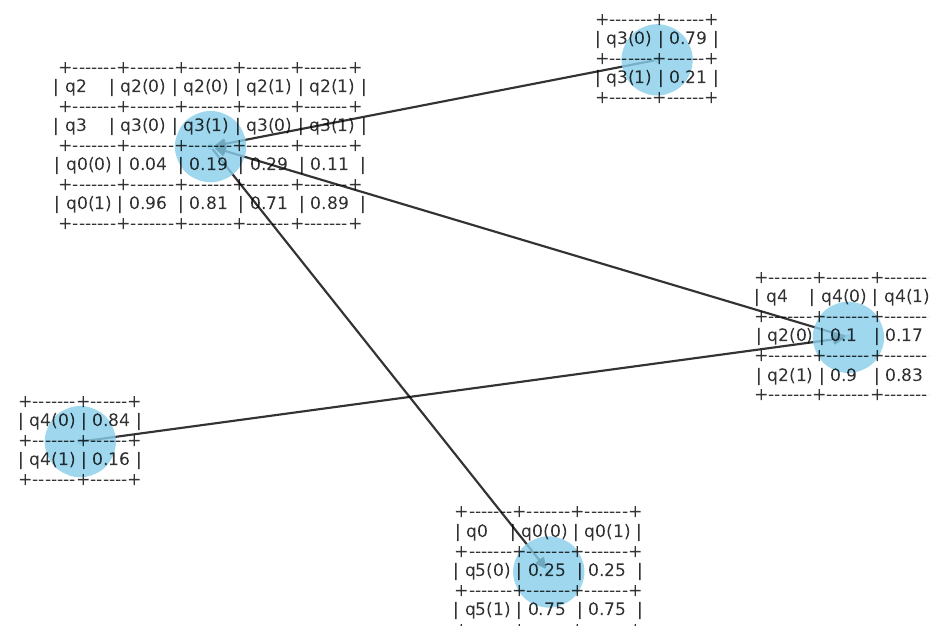
Figure 6. Equivalent Bayesian network to the quantum digital twin shown in Figure